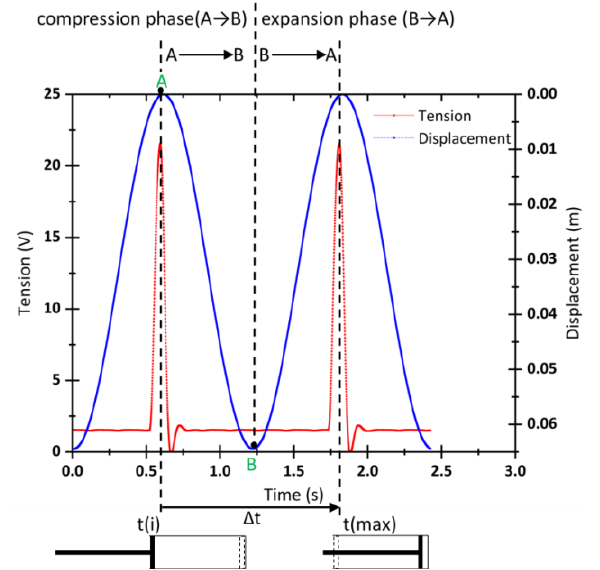
Figure 5. Example of the experimental angle sensor signal and of the theoretical piston position.